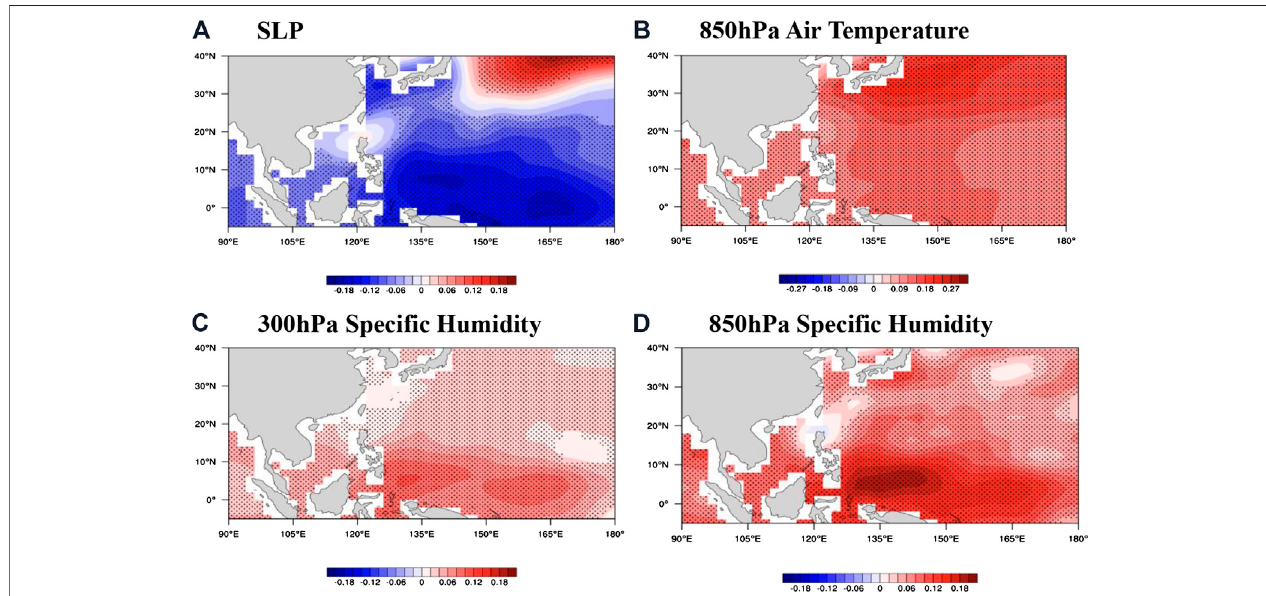
FIGURE5| Theregressionmapsof (A) sealevelpressure(unit:hPa), (B) 850 hPaairtemperatureanomalies(unit:K), (C) 300 hPaspeci fi chumidityanomalies(unit: g · kg -1 ), and (D) 850 hPa speci fi c humidity anomalies (unit: g · kg -1 ) onto the normalized AMO index for 1950 – 2010 in 20CR reanalysis data. Dotted shading in (A – D) represents the regression coef fi cients signi fi cant at the 95% con fi dence level. The long-term linear trends for 1950 – 2010 in all variables were removed before the regression analysis.